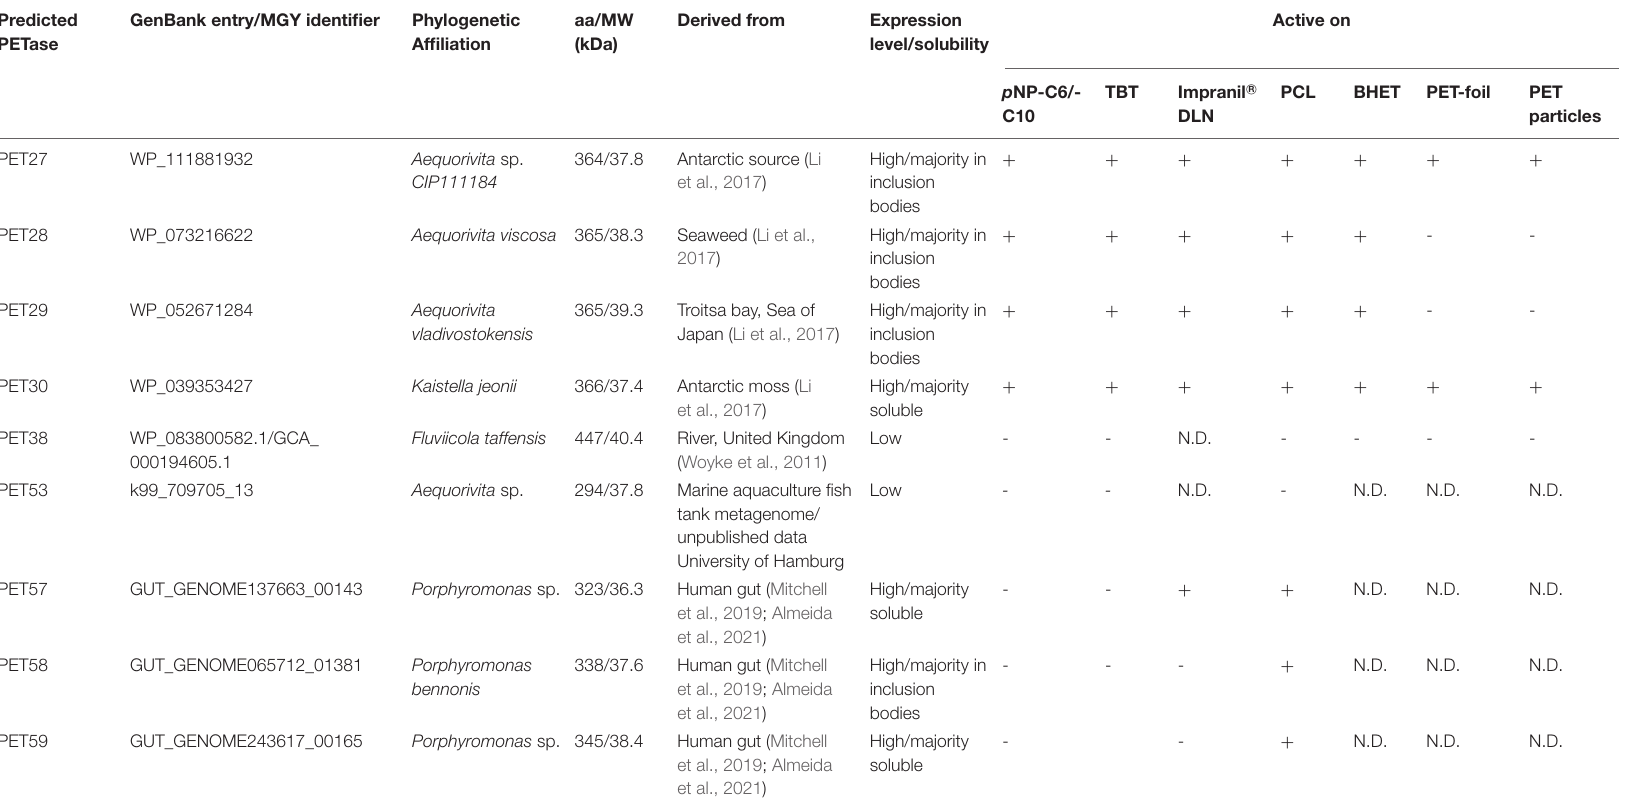
TABLE 1 | Key traits of predicted bacteroidetal PET